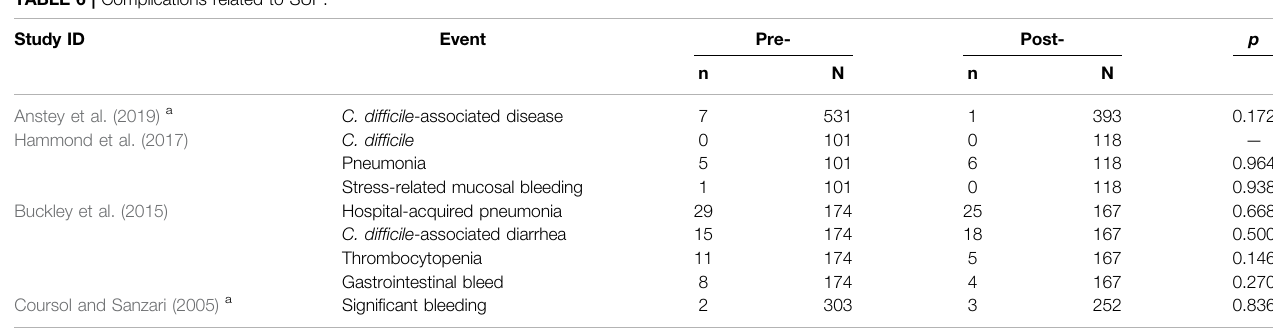
TABLE 6 | Complications related to SUP.